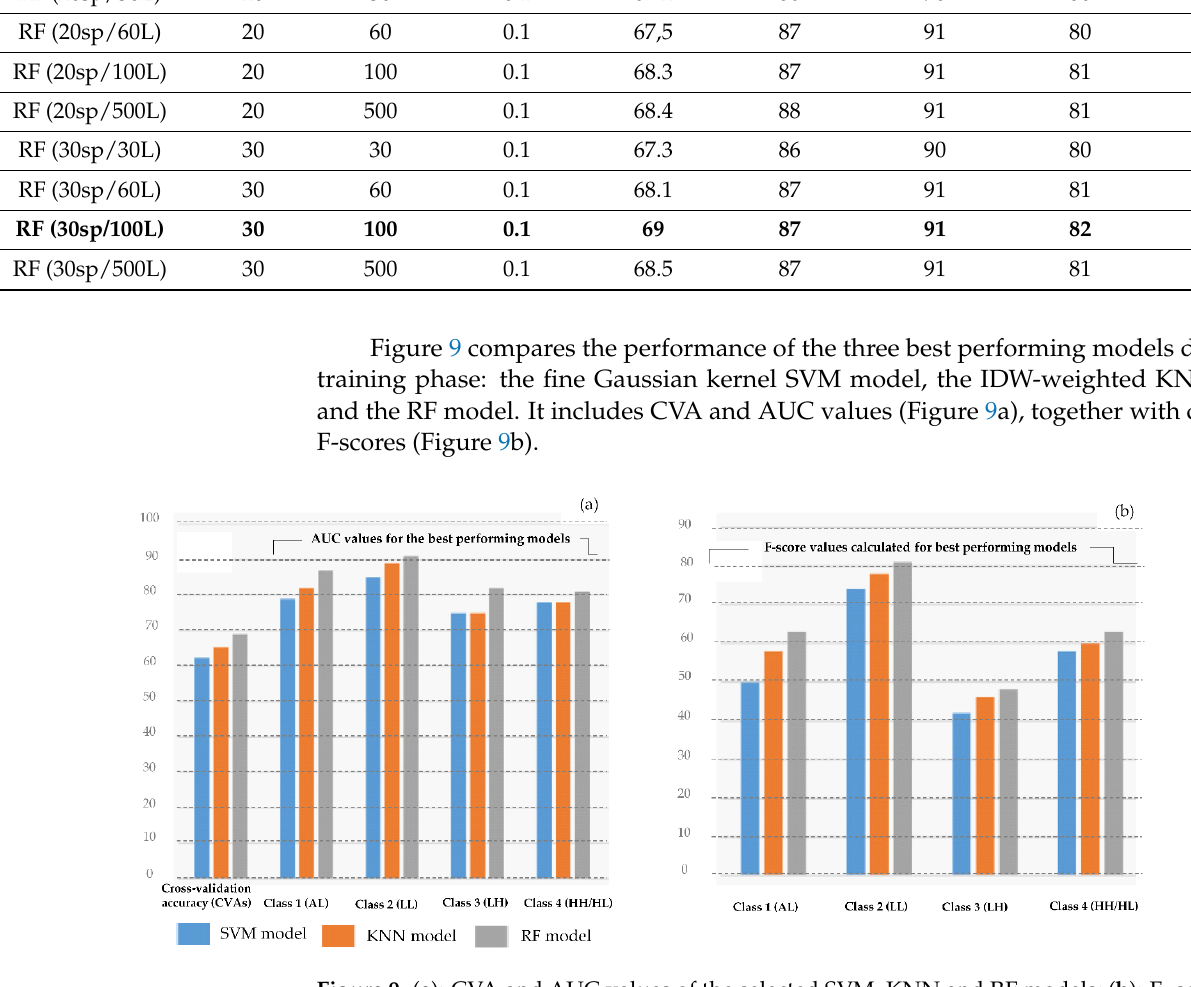
Figure 9. ( a ): CVA and AUC values of the selected SVM, KNN and RF models; ( b ): F ‐ scores of the different models for the four classes. Overall, predictive abilities of the three models are comparable. They are higher for Class 2, and decrease slightly for Classes 1, 3 and 4. The different indicators (CVA, AUC, and F ‐ score values) indicate that the KNN model is slightly better than the SVM model, but the differences appear negligible. The RF model is systematically superior to SVM and KNN, particularly for Classes 1, 2 and 4. The calculated F ‐ scores (Figure 9b) confirm the slightly higher performance of the RF model in this study, compared to SVM and KNN. Most importantly, each of the three models could be used to predict mineral targets, given the minimal differences between them. 6.3. Evaluation of Robustness of Output Models In step S5 of the methodological approach (see Figure 3), several metrics were con ‐ sidered for evaluating the performance and robustness of the different SVM, KNN and RF classifiers (see Section 3.5 for details). Good performance using training dataset 3 does not guarantee that the model is sufficiently robust and that it is able to perform on new datasets against which it has not been previously trained. Therefore, the performance and robustness of the output SVM, KNN and RF, those identified as best for each category, were validated using the independent validation dataset 4 (composed with 20% of the original dataset 2). The resulting confusion matrices for each category (KNN, SVM, and RF) were analyzed considering CVA, AUC values and Kappa coefficients. Kappa values were interpreted according to the scale proposed by Landis and Koch [82]. Table 8 shows confusion matrices that were obtained during the independent validation phase. Table 8. Confusion matrices that were obtained during the independent validation phase. Fine Gaussian Kernel SVM Confusion Matrix (Values are in %) Class 1 (AL)